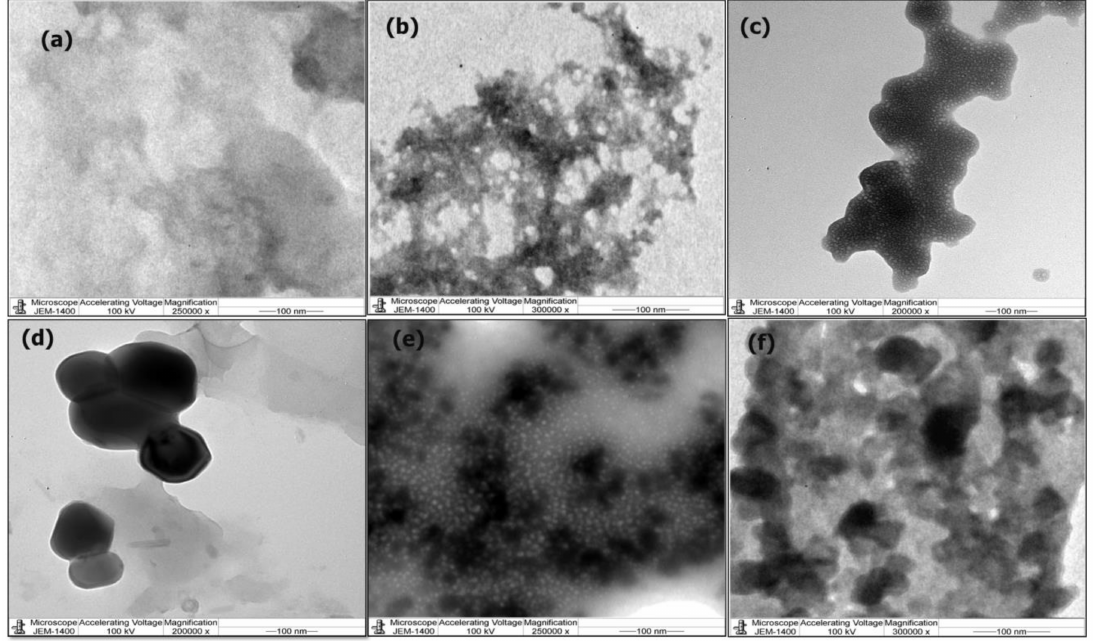
Figure 4. HRTEM images of ( a ) pure CS, ( b ) CS-Ins, ( c ) CS-g-SA-Ins, ( d ) CS-g-OA-Ins, ( e ) CS-g-LA-Ins, and ( f ) CS-g-LLA-Ins